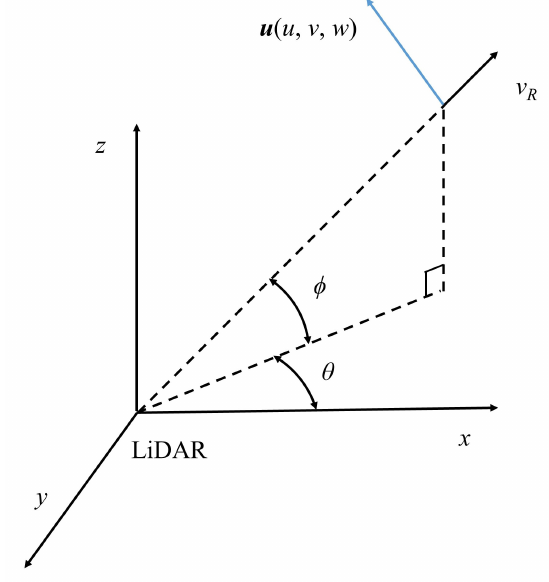
Figure 2. Wind measurements from the coherent LiDAR system. v R , θ and φ represent the radial velocity, the azimuth angle, and the elevation angle